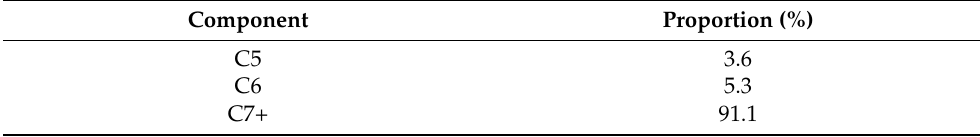
Table 5. Oil properties used to prepare fluid model.